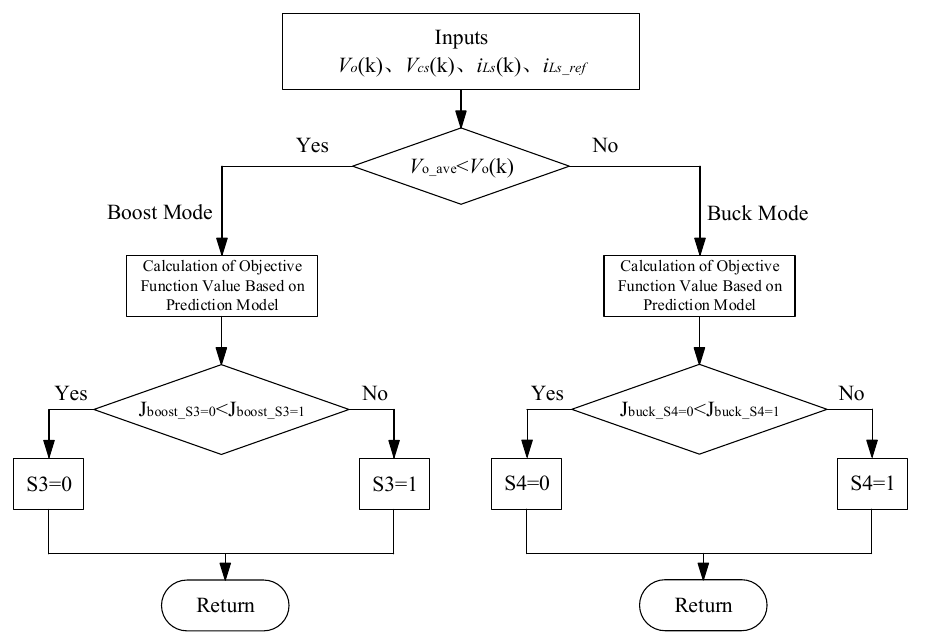
Figure 7. Flow chart of model predictive current control.